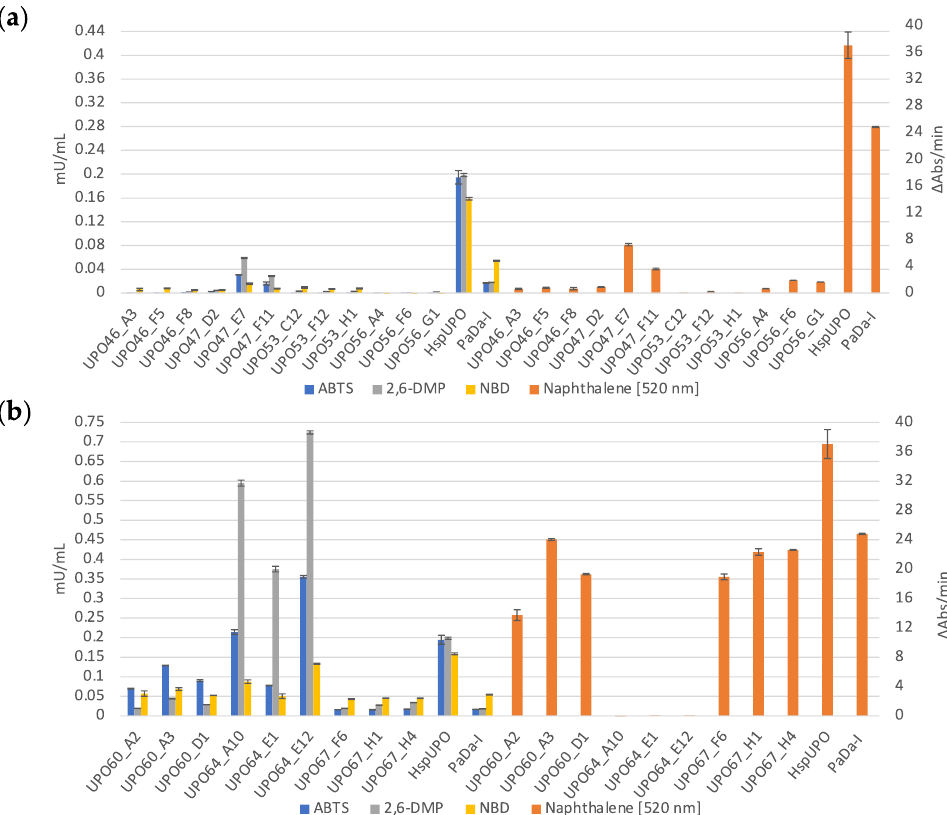
Figure 3. Enzymatic activities of shake flask supernatants from K. pfaffii strains expressing novel ( a ) family II (long) and ( b ) family I (short) UPOs. Each strain was cultivated in triplicates and enzymatic activities of supernatants were determined. The different strains per UPO target were named according to the shortcut (e.g., UPO46) and a clone designation reflecting the position of this clone in the initial cultivation (e.g., _A3). For substrates ABTS, 2,6-DMP and NBD, values are depicted as units volumetric activity in (mAU/mL) using the extinction coefficients of the reaction products, as described in literature (ABTS: ε (405) = 36,000 1/M*cm [34] 2,6-DMP: ε (469) = 27,500 1/M*cm [35], NBD: ε (425) = 9700 1/M*cm [33]). For conversion of naphthalene, enzymatic activities are given as change in absorbance at 520 nm over time ( ∆ Abs/min). Error bars represent standard deviation of technical triplicate measurements. All values are corrected by the measurements for the control strain not expressing any target protein.